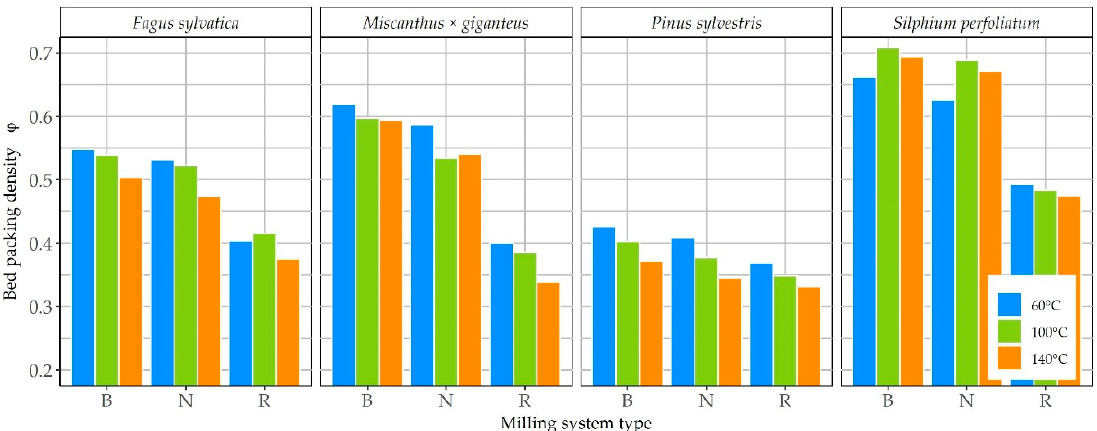
Figure 9. Bulk density changes in the material before and after grinding; R is the initial material, B is the hammer, and N is the knife grinding system. Energies 2020 , 13 , x FOR PEER REVIEW 13 of 22